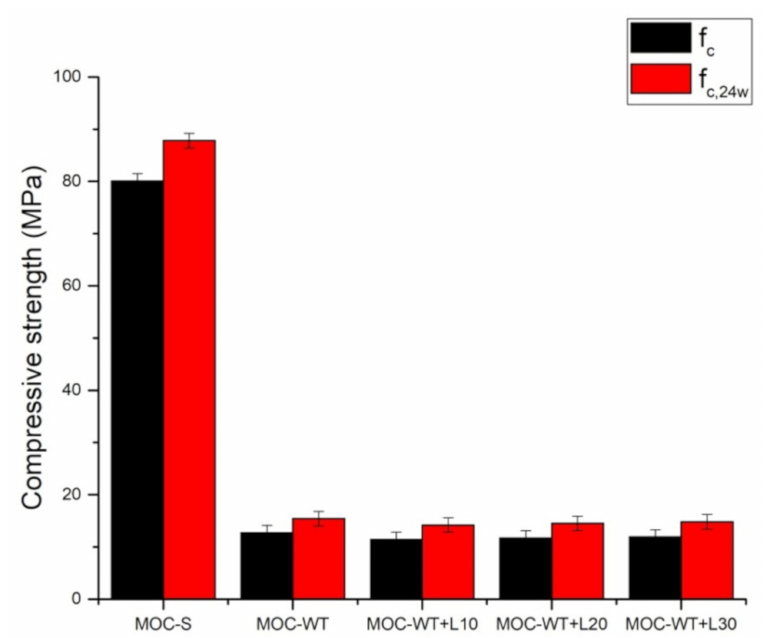
Figure 6. Comparison of the control compressive strength and that of samples exposed to water.